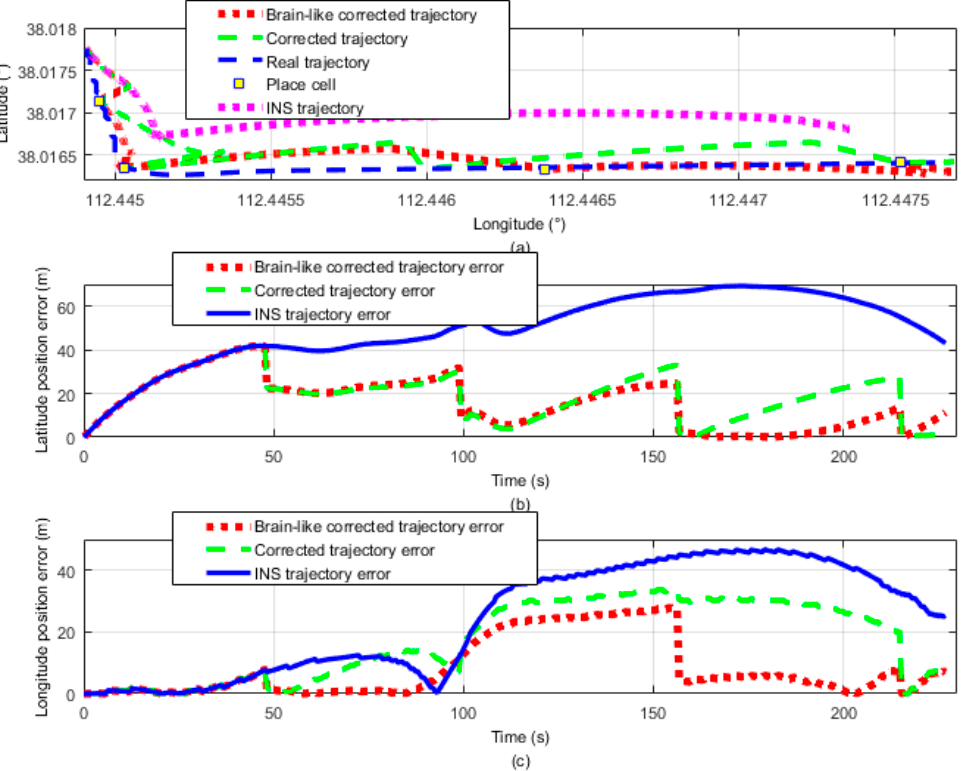
Figure 9. Place and error experimental results. ( a ) Trajectory; ( b ) Latitude error; ( c ) Longitude error. Table 1. Latitude and longitude errors (m). SD: standard deviation; INS: inertial navigation system; RMSE: root-mean-square error.